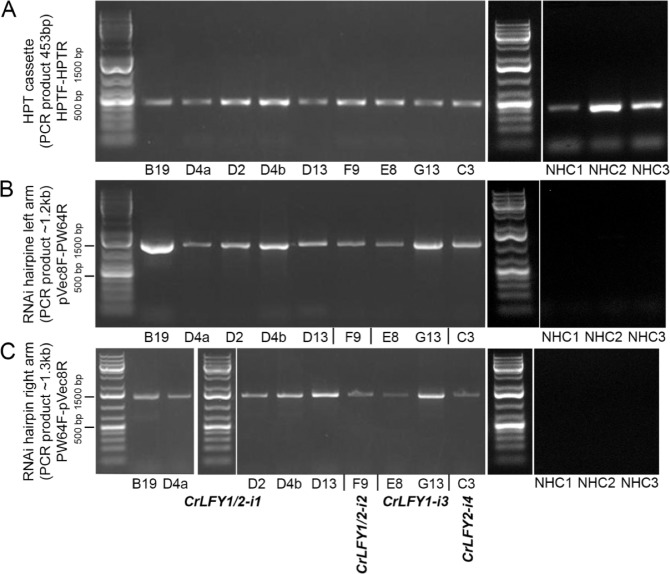
Genotyping PCR confirms the presence of CrLFY RNAi T-DNA in transgenic lines and the absence of the RNAi hairpin in no hairpin control lines.PCR was performed on genomic DNA extracted from T1 sporophytes pre-selected for antibiotic resistance. The presence of the HPT cassette (A) was confirmed in all lines by PCR. The presence or absence of both arms of the RNAi hairpin (B, C) were confirmed in each line by PCR, and where sequenced the amplified products were as expected.